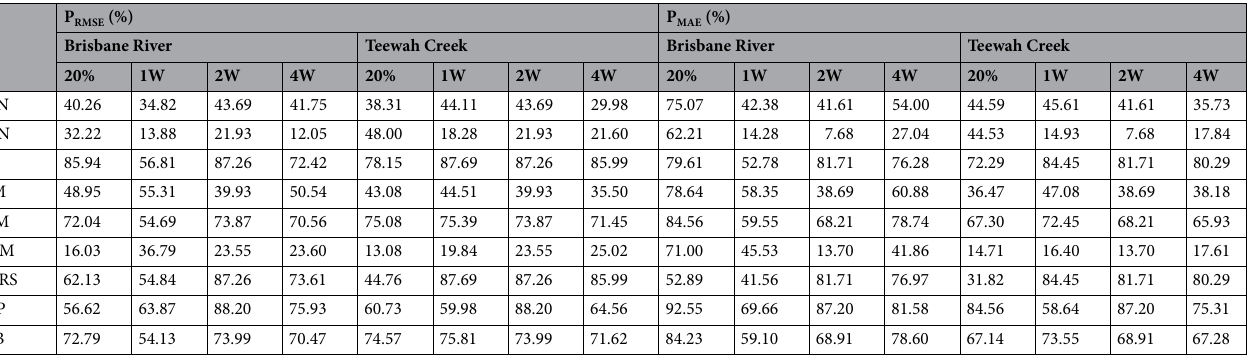
Table 8. Promoting percentages of the comparison models [Convolutional Neural Network (CNN) and Long Short Term Memory Network (LSTM) as well as the Deep Neural Network (DNN), Multi-Layer Perceptron